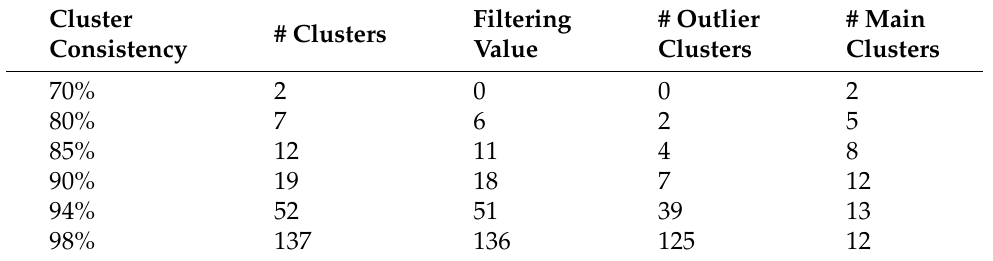
Table 3. A summary of the number of clusters formed by considering different cluster consistency